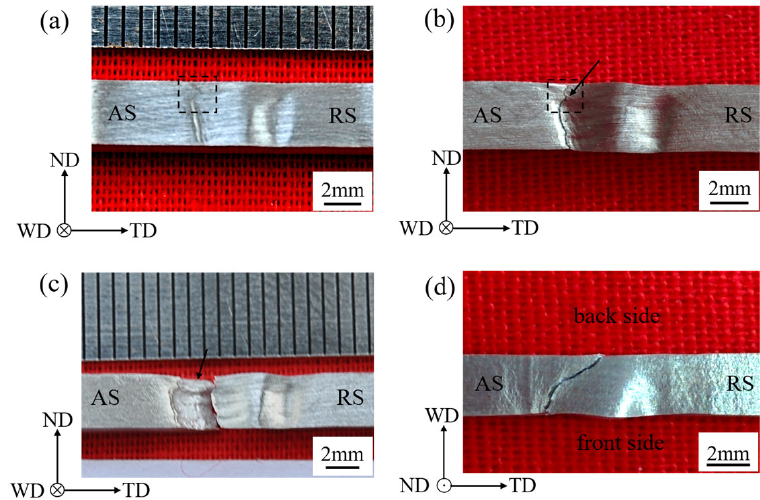
Figure 6. Photographs: ( a ) at 90% ultimate tensile strength (UTS), ( b , c ) after fracture on the front side of FSW samples, ( d ) after fracture on the top side of FSW samples. The triple junction region is marked with the black dotted rectangle in ( a , b ).